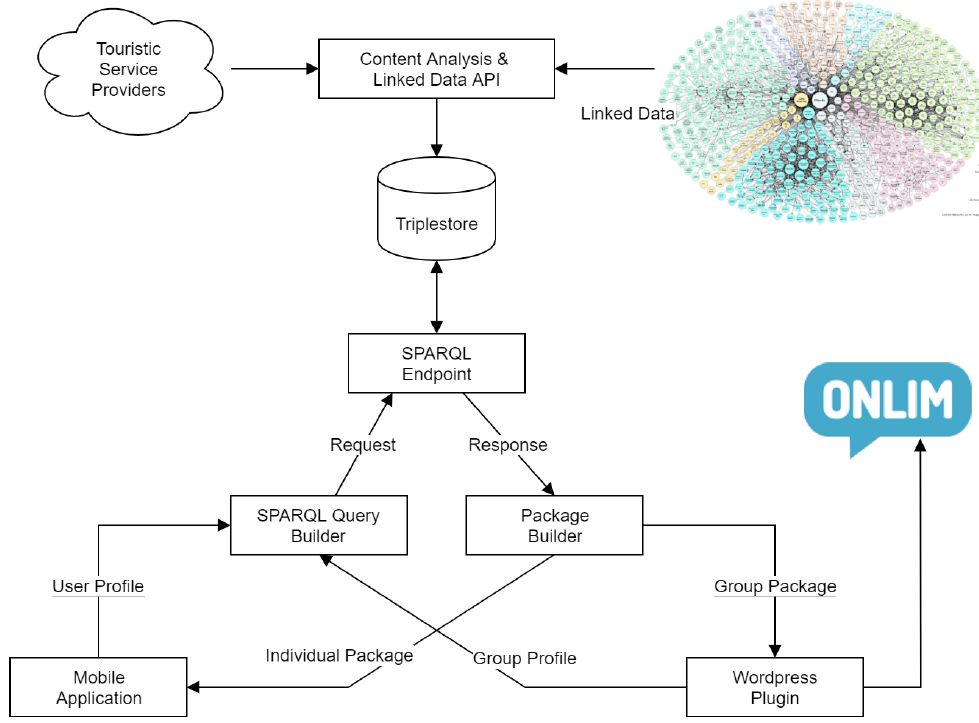
Figure 1. TourPack linked data-based content management